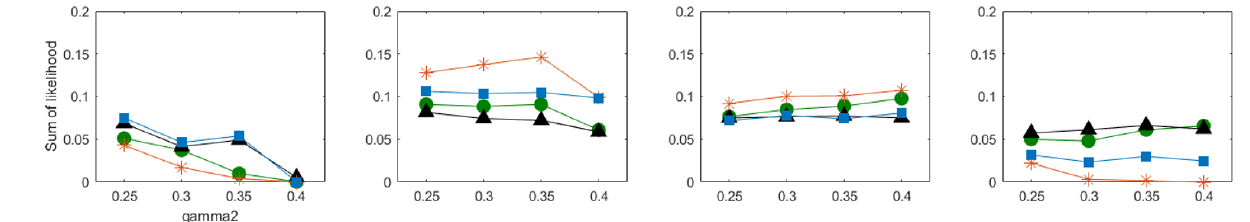
Figure 11. Sum of the likelihood of three key parameters ( alpha , gamma , and gamma2 ) at each fixed facua . The higher sum of likelihood indicates that higher BSS values are distributed at the parameter value. In addition, large variance of the sum of likelihood distribution indicates a high model sensitivity within given parameter combinations and incident wave conditions.